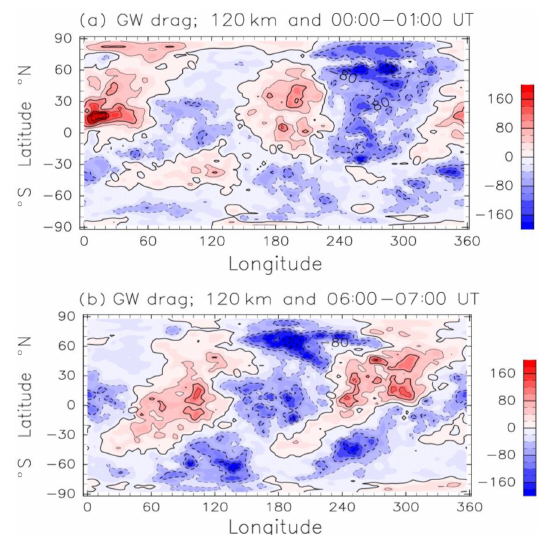
Figure 9. (a) Latitude–longitude section of the zonal GW drag at 120km height in June. Data are averaged between 00:00 and 01:00UT. Positive and negative values are eastward and westward acceleration, respectively. Units are meters per second per day. Con- tour intervals are 40ms − 1 d − 1 . (b) As in (a) except for the average between 06:00 and